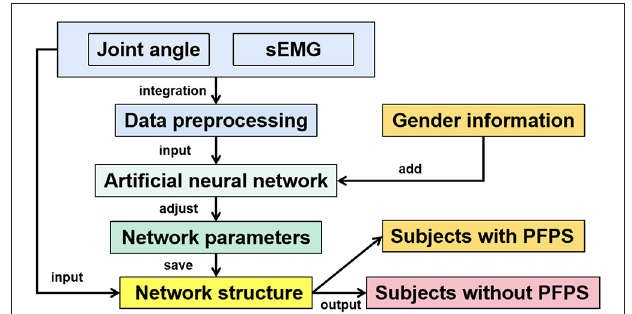
FIGURE 2 | Overall flow chart of the